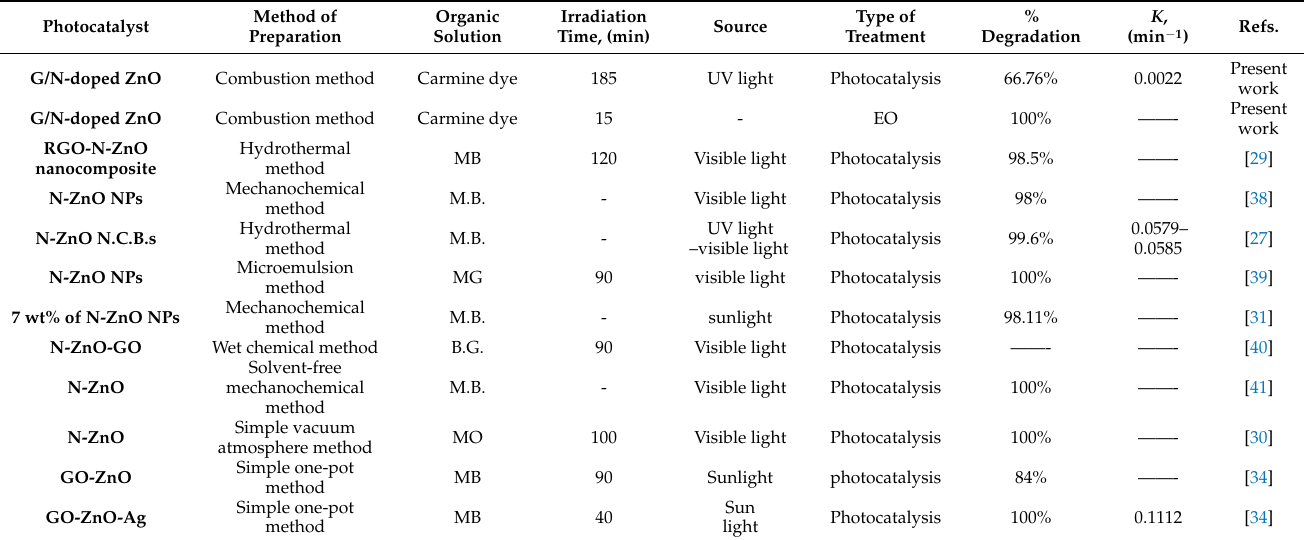
Table 3. Comparison of photocatalytic degradation of carmine and different dyes in the presence of N-doped ZnO with other previous work